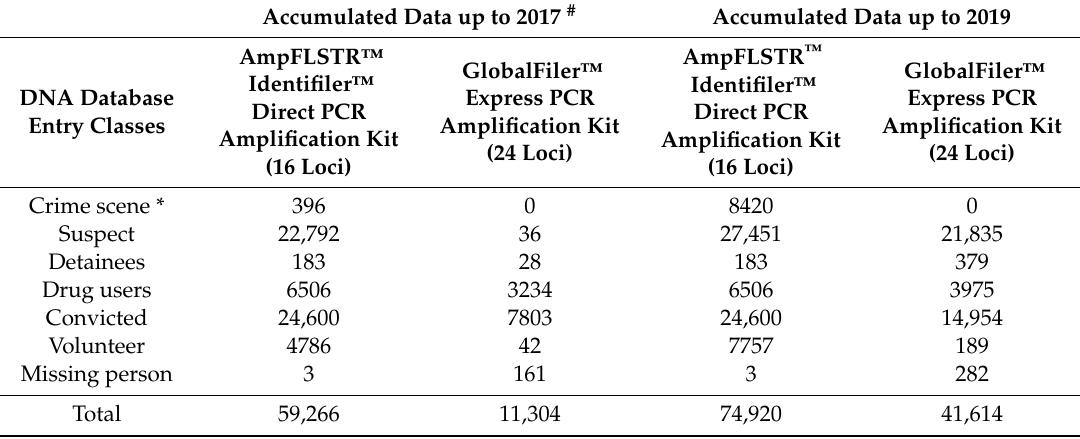
Table 1. Types and numbers of DNA profiles stored in the Forensic DNA Databank of Malaysia (FDDM) for 2017 and 2019.